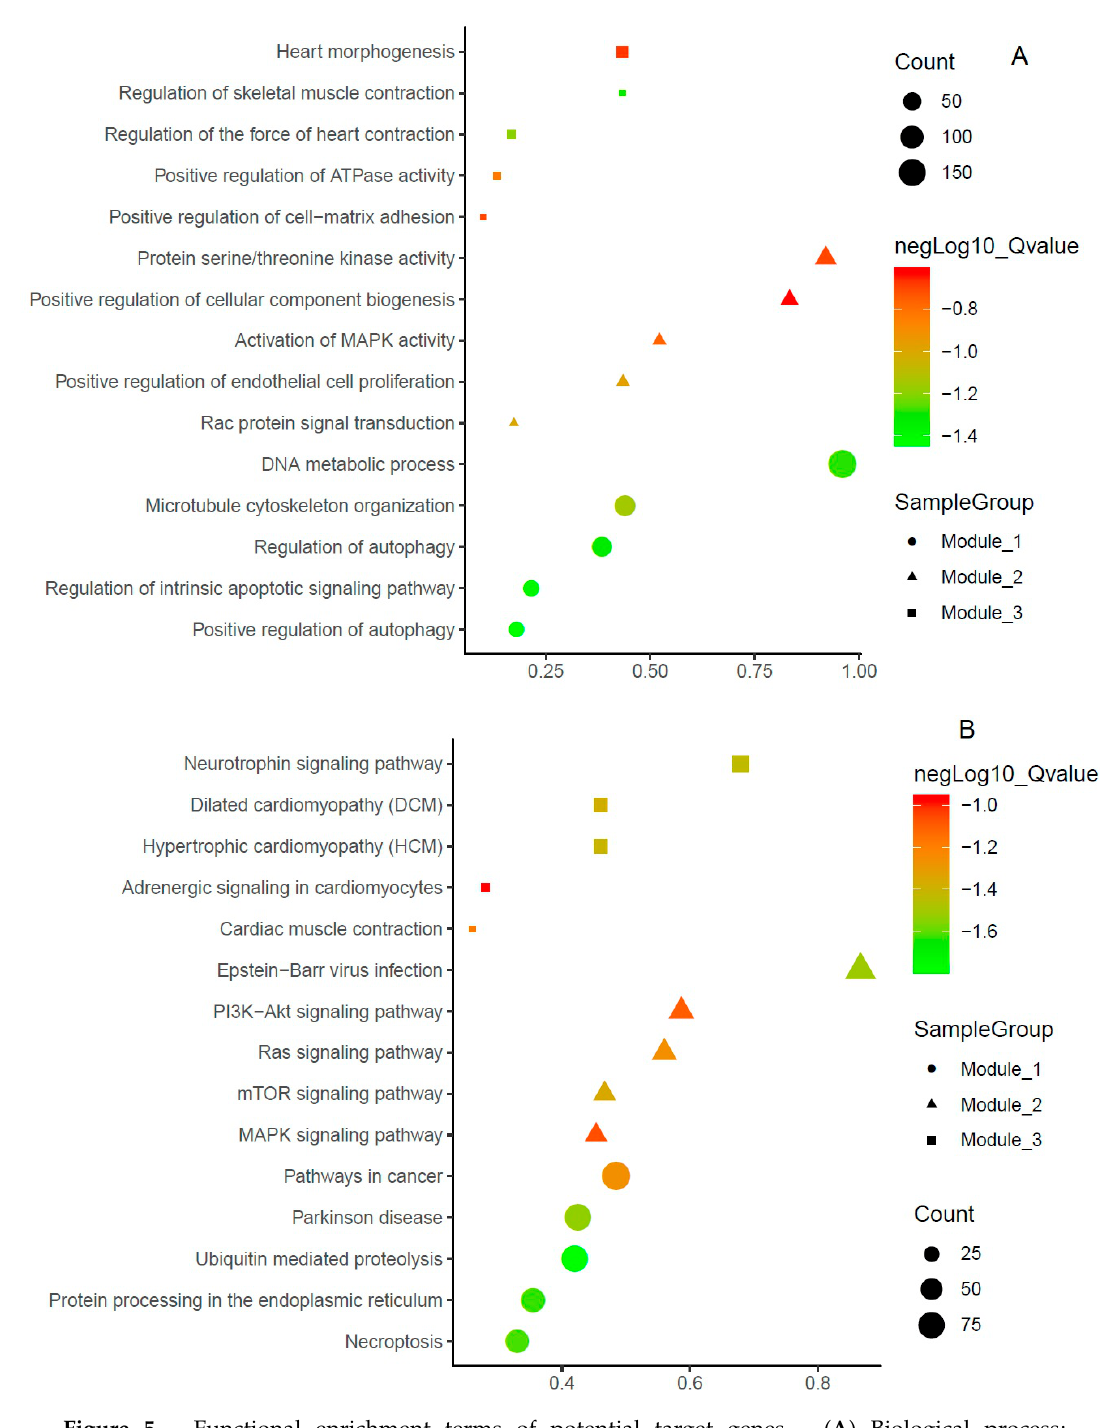
Figure 5. Functional enrichment terms of potential target genes. ( A ) Biological process; ( B ) KEGG pathways.